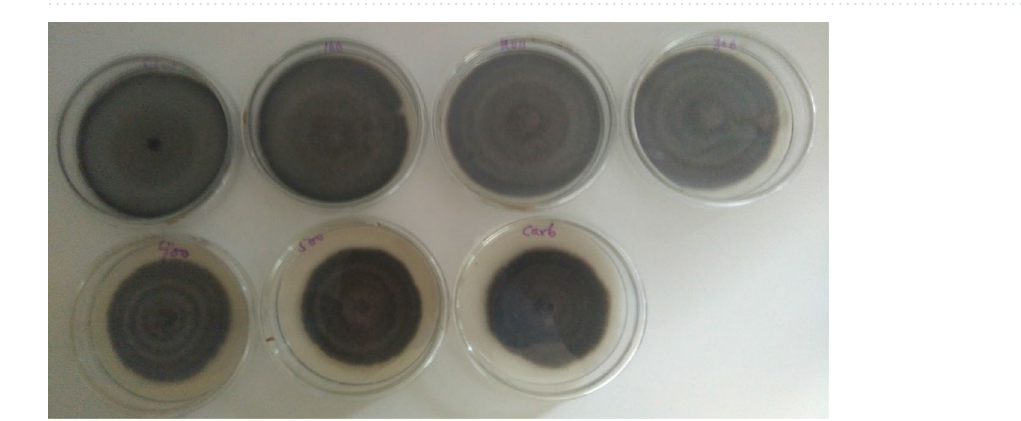
Figure 1. Curvularia species growing on PDA amended with different concentrations of wood vinegar and carbendazim at day 6. (Top row L–R; Control, 0.67, 1.34, 2.01 (%), bottom row L–R; 2.68, 3.35 and Carbendazim